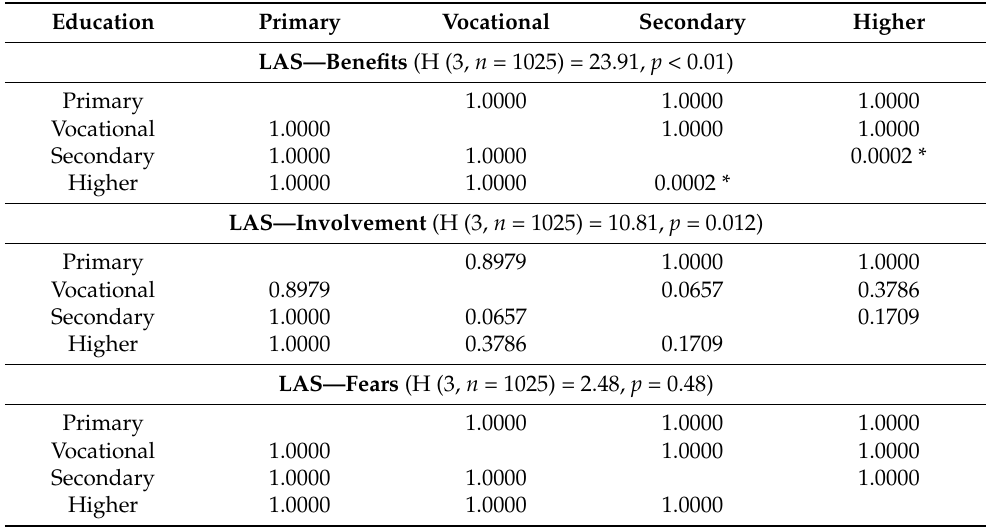
Table 4. Significance of difference between groups in reference to education level—results of post-hoc analysis.